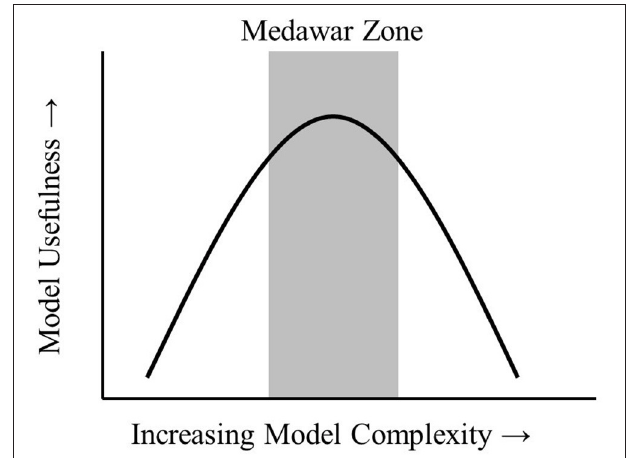
FIGURE 1 | The Medawar Zone. As models increase in complexity, the Medawar Zone is the region of maximum usefulness. Adapted from Grimm et al. (2005) (permission